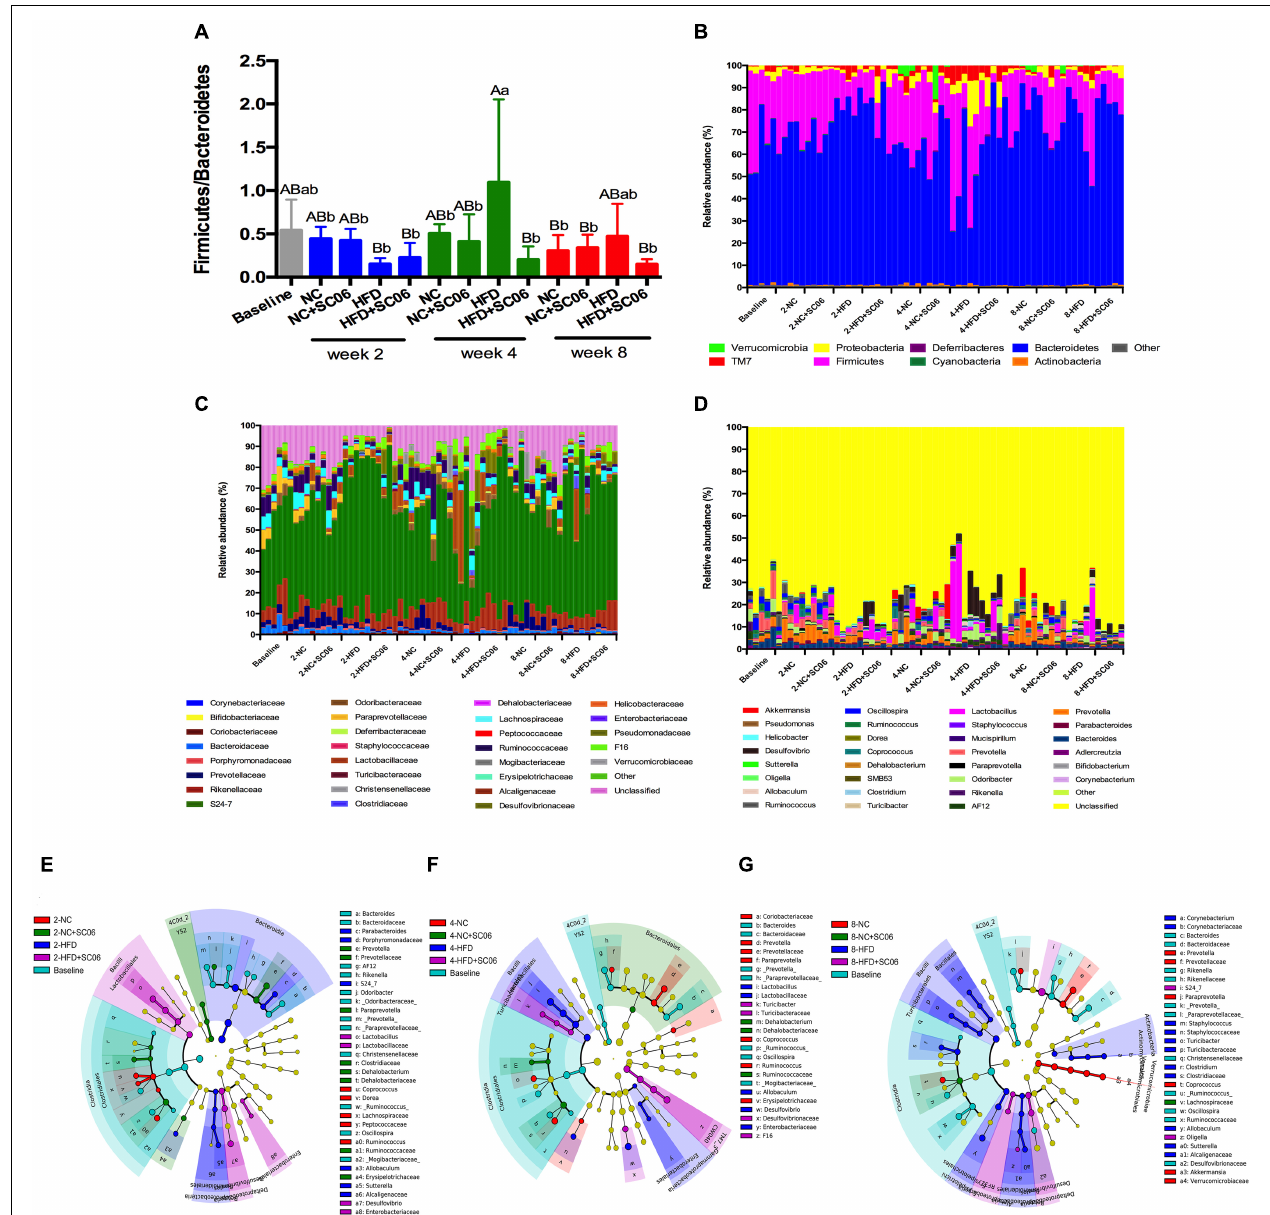
FIGURE 6 | SC06 administration changed gut microbiota. (A) The ratio between Firmicutes and Bacteroidetes of gut microbiota, (B) phyla, (C) families, (D) genus of mice. Cladogram plotted from LeFSe analysis showing the taxonomic levels represented by rings with phyla in the outermost the ring and genera in the innermost ring. Each circle is a member within that level. (E) Week 2, (F) week 4, and (G) week